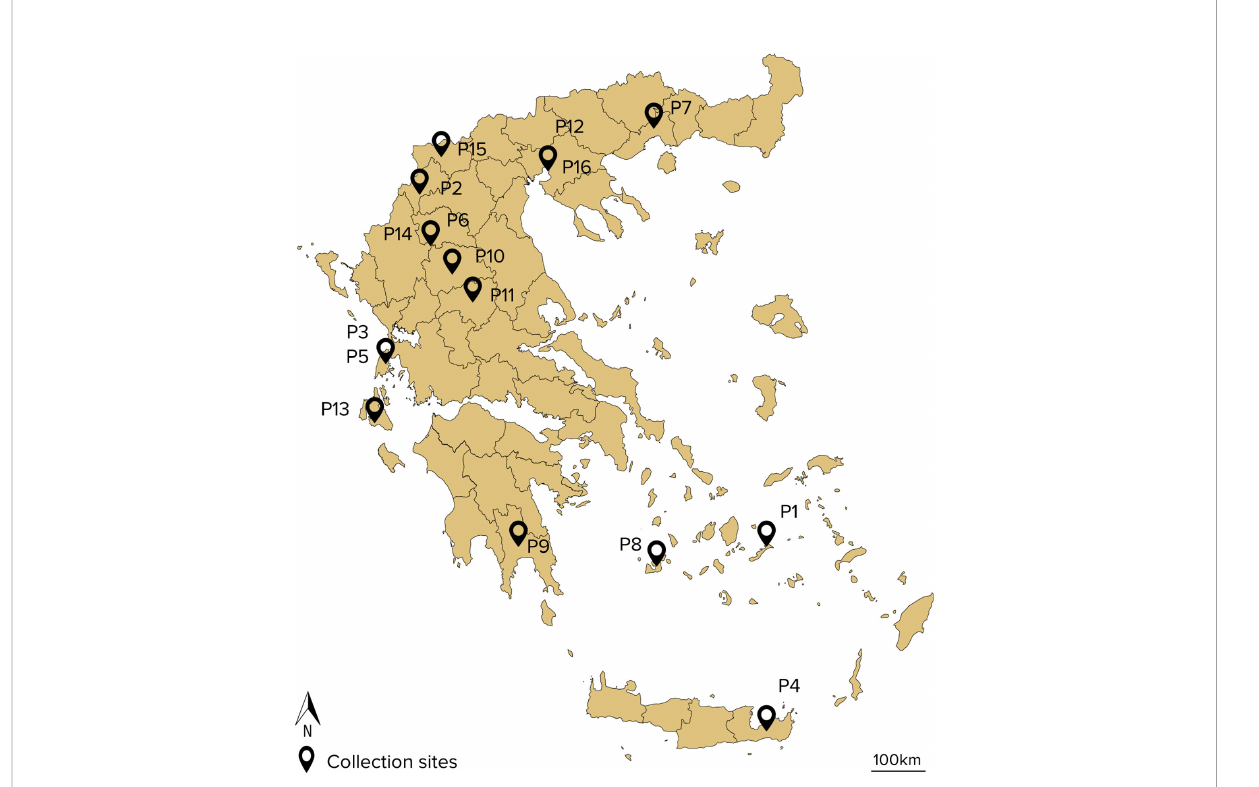
FIGURE 1 Map of the collection sites of lentil accessions used in the study (Google,